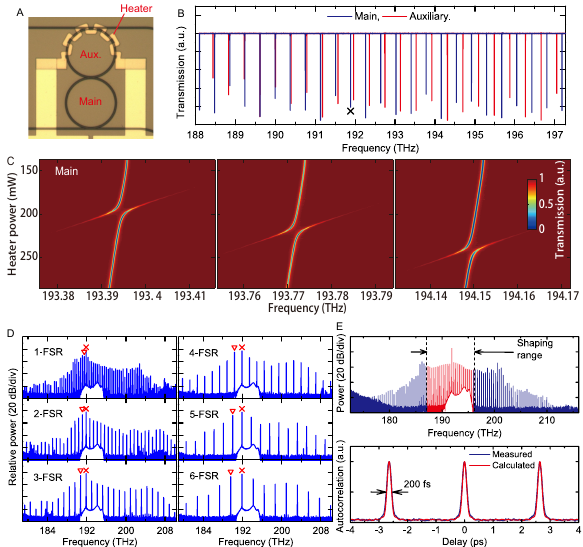
Figure 22: Reliable comb generation with dual-coupled microres- onators. (A) Microscope image of dual-coupled Si 3 N 4 microrings. The radii of the main and auxiliary rings are 60 and 58 µm, re- spectively. The cross-section dimension of the ring waveguide is 1.3 µm×600 nm. The coupling gap between the two rings is 600 nm. (B) Transmission of the two rings measured at their respective bus waveguide. The FSRs of the main and auxiliary rings are 378 GHz and 391 GHz, respectively. (C) Transmission spectroscopy of the main ring when the mode splitting is tuned by thermally tuning the auxiliary ring. (D) Repetition rate selectable comb generation. The comb line marked with “×” is the pump line; the comb line marked with “ ∇ ” is where mode crossing happens. (E) Upper: spectrum of a broadband mode-locked comb after transition to a low-noise state; lower: autocorrelation of the compressed pulse after line-by-line phase compensation. Adapted from Ref.